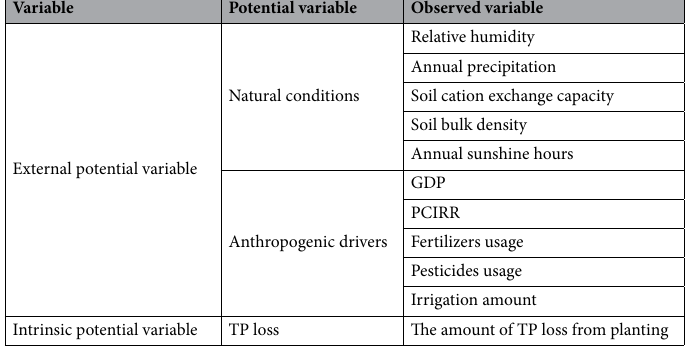
Table 1. Variable systems of TP loss, natural conditions and anthropogenic drivers established for